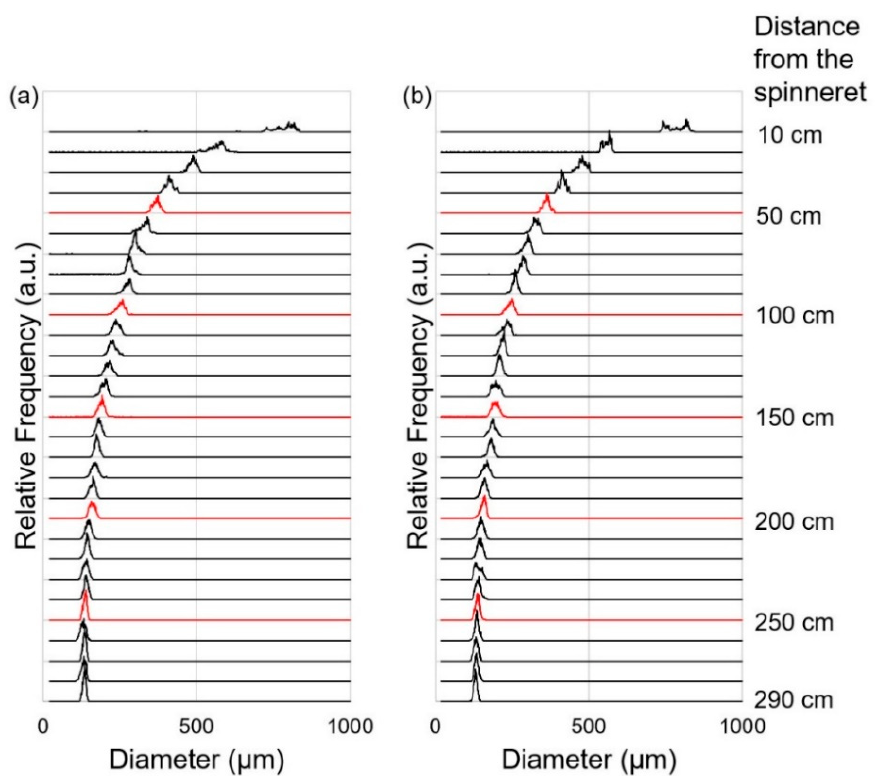
Figure 4. Diameter frequency diagrams measured for various positions of melt spinning line for the take-up velocity of 0.5 km/min; ( a ) virgin PP, and ( b ) recycled PP.